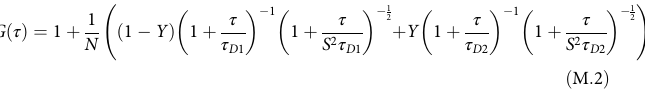
FCS measurements . FCS measurements on cells expressing mEmerald-integrin β 3 N-18 or mEmerald-integrin β 1 N-18 were performed on Zeiss LSM 780 system as previously described 38 using a 40x C-Apochromat W (NA 1.2) water immersion objective. mEmerald-tagged proteins were excited with 488-nm argon ion laser line (0.5% transmittivity). Fluorescence emission was collected on gallium arsenide phosphide detector collected through the 488nm main beam splitter collecting emission light from 498 – 596 nm. The focal volume was calibrated with 10 nM Rhodamine 6G solution ( D = 2.8 ×10 − 6 cm 2 /s). For each cell, a pre-bleaching step was performed using 100% laser power for 5 s and then subsequent illumination with 0.5% transmittivity. FCS measurements were recorded at 25 °C in HBSS supplemented with HEPES and Pyruvate for 50 s (5 consecutive 10 s intervals). FCS data were fi tted to a two-dimensional diffusion model shown by the